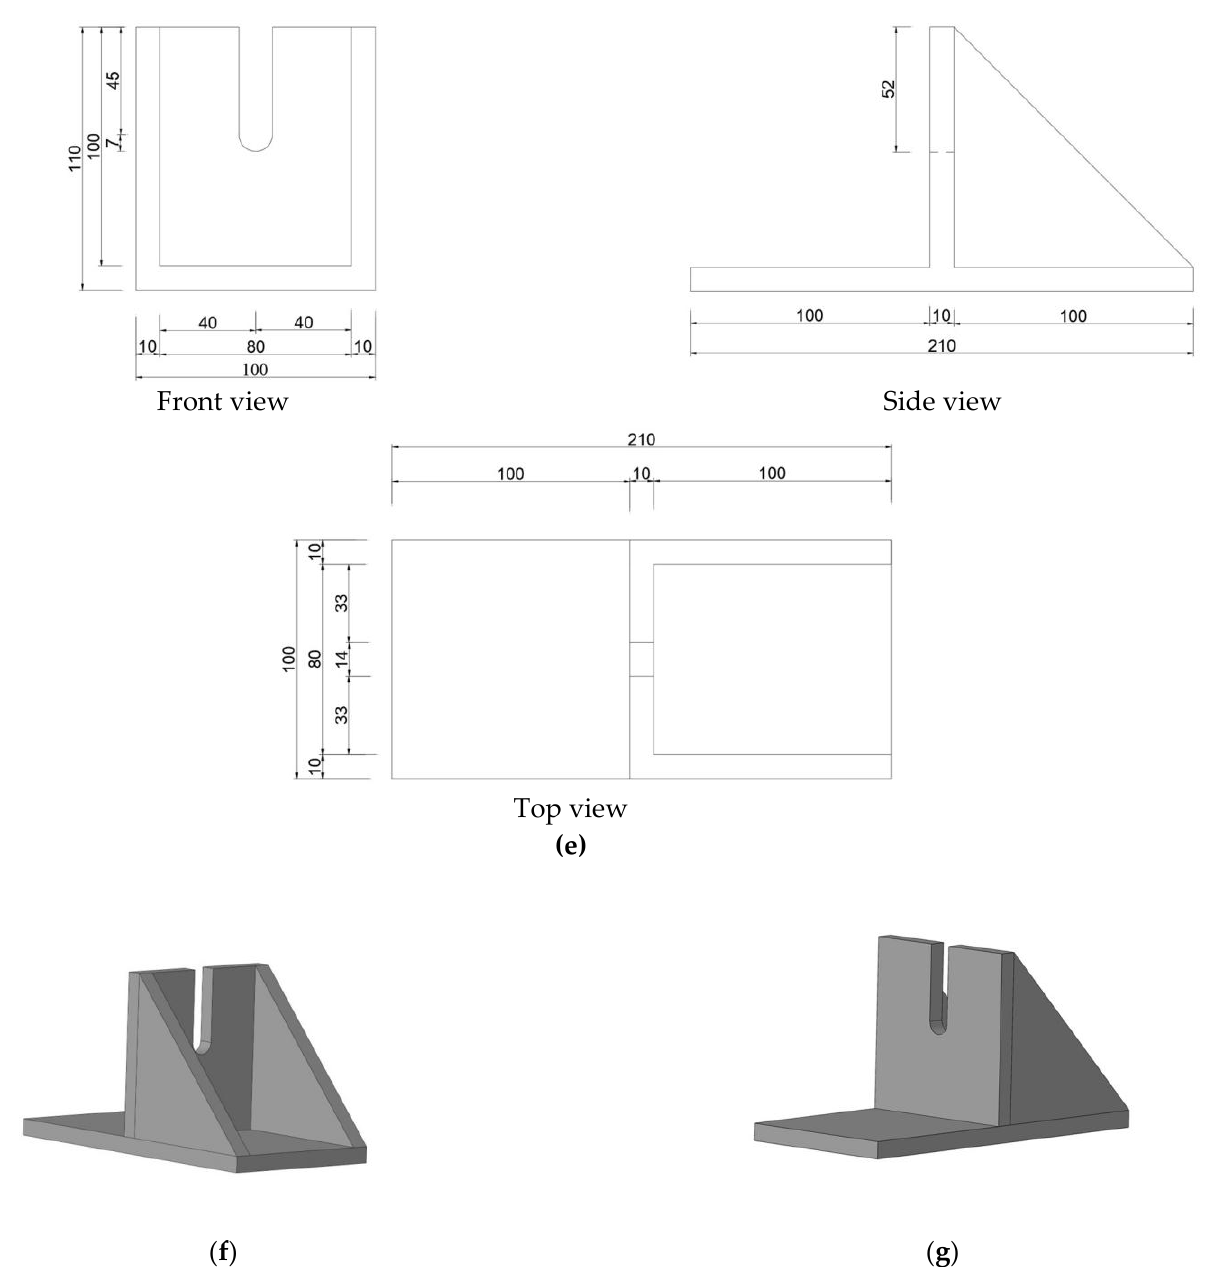
Figure 1. The diagrammatic chart of the connector. ( a ) Upper node, three views. ( b ) Upper node. ( c ) The L-node plate. ( d ) The Z-node plate. ( e ) Lower node, three views. ( f ) Front of lower node. ( g ) Side of lower node.